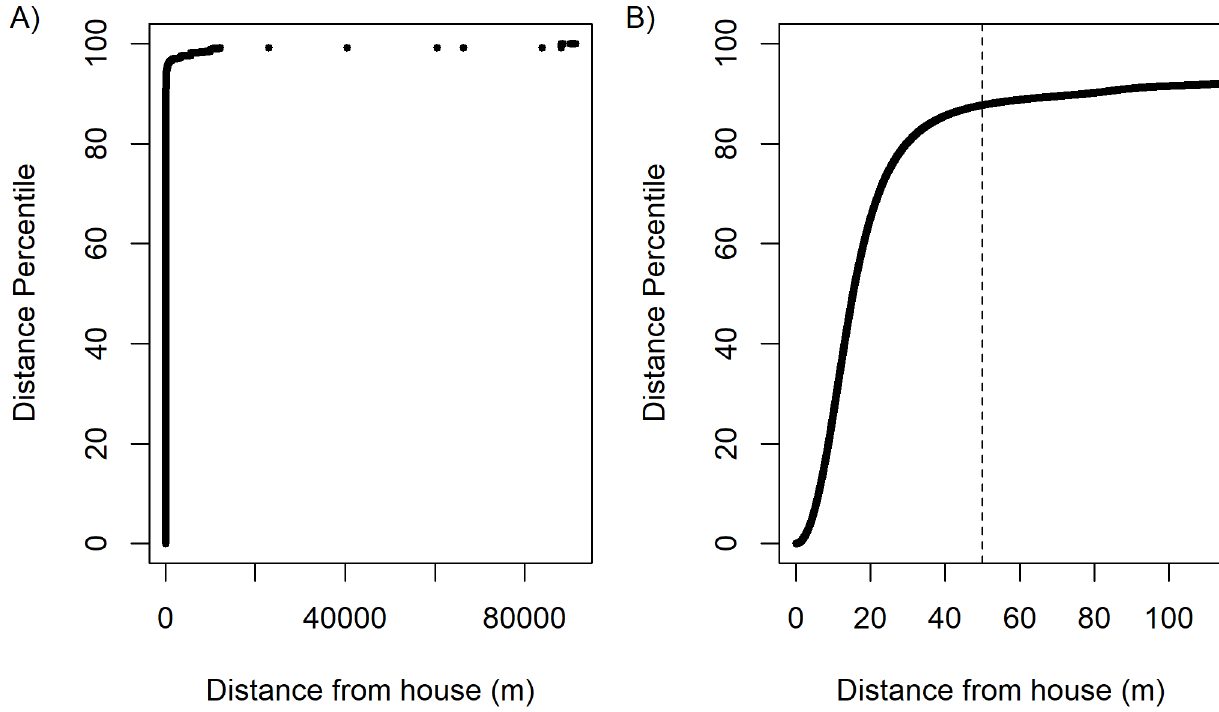
Fig 1. Distances of GPS points from the wearer’s house. We calculated the distance between each GPS point and the wearer’s home and converted these distances into percentiles. While the maximum distance is approximately 88,000 meters (A), zooming in on the 100 meters closest to the house (B) indicates that the majority of points occur near the home. The dashed line marks 50 meters, within which 87.7% of all GPS points fall.